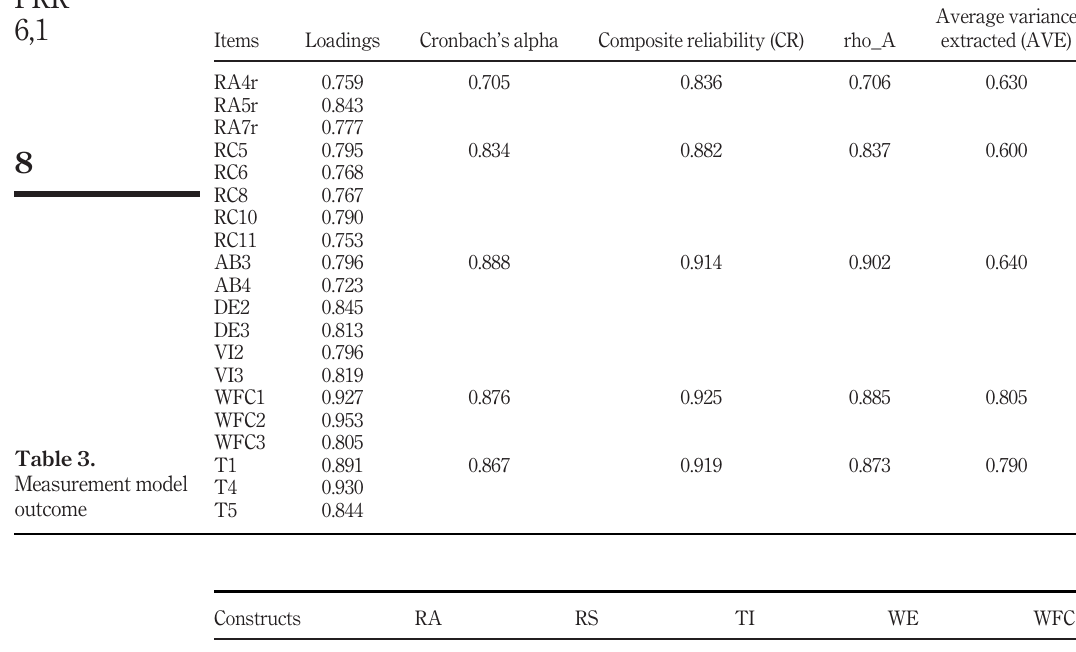
Table 4. Fornell Larcker test